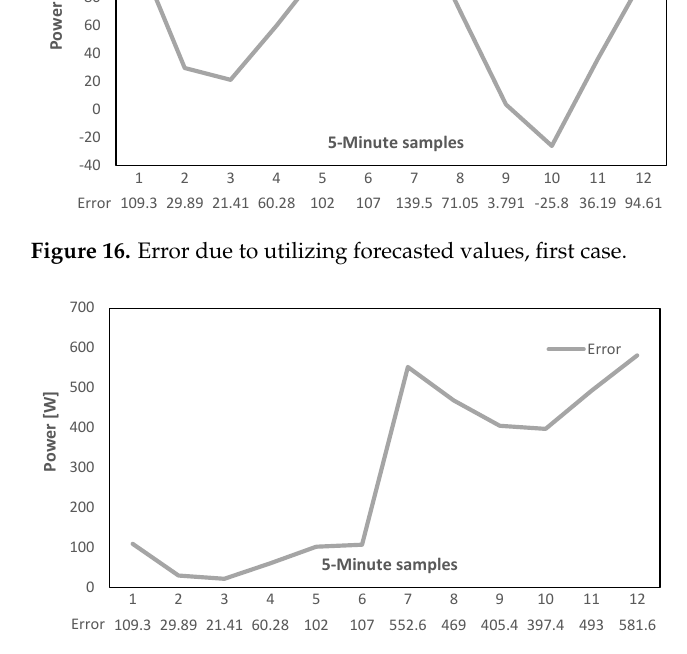
Figure 17. Error due to utilizing forecasted values, second